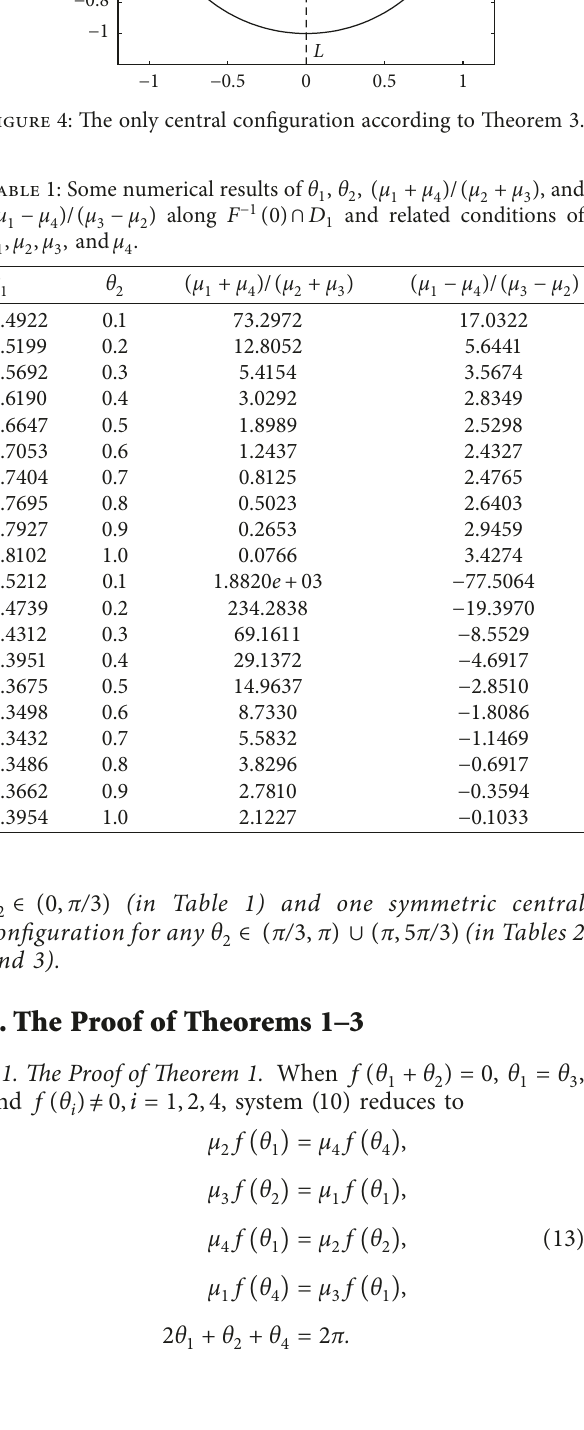
+ μ ) / ( μ + μ ) , and , θ , ( μ 1 2 1 4 2 3